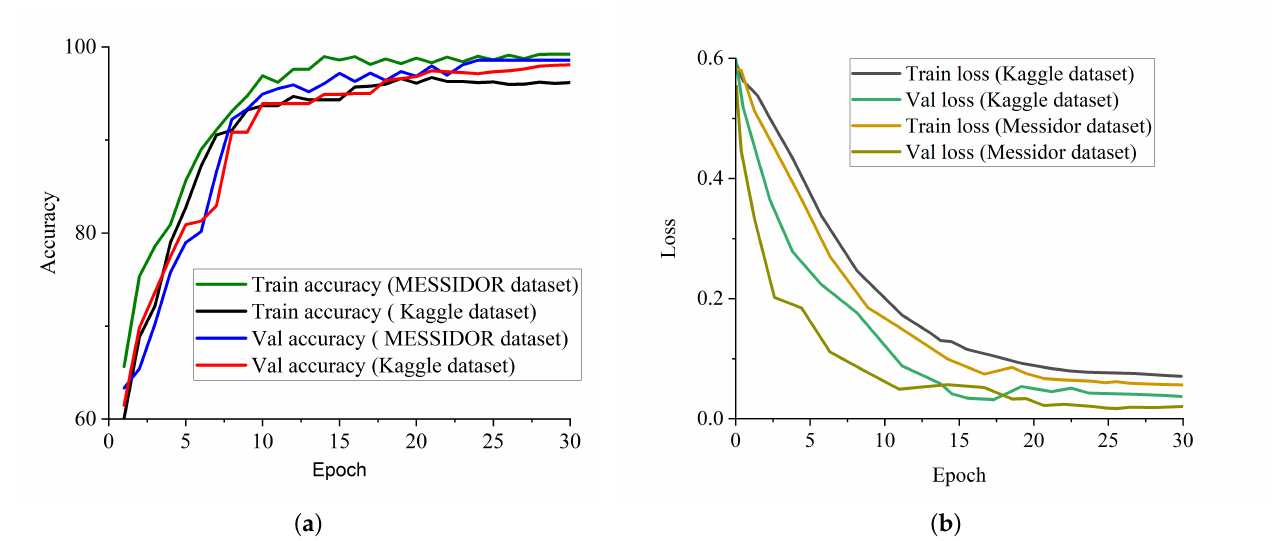
Figure 8. Training and validation performance report of our proposed model on both Messidor and Kaggle datasets. ( a ) Accuracy curve for our proposed model on both Kaggle and Messidor datasets. ( b ) Loss curve for our proposed model on both Kaggle and Messidor datasets.